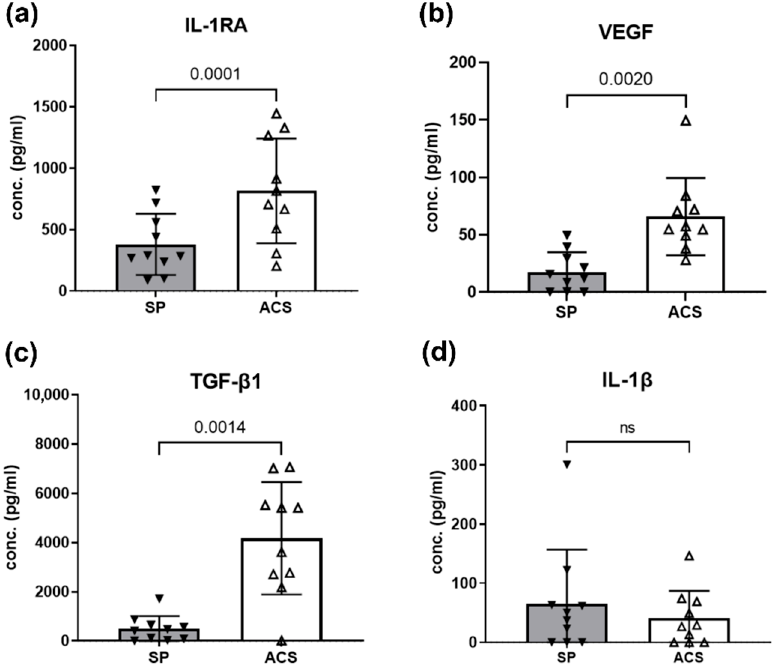
Figure 1. Growth factor and anti-inflammatory cytokine levels of ACS and SP derived from dogs with spontaneous OA. Bar graphs show the cytokine components in response to ACS as evaluated by ELISA. The levels of ( a ) IL-1RA, ( b ) VEGF, and ( c ) TGF- β 1 in the ACS group were significantly higher than in unprocessed plasmas. P values were reported as indicated. There was a limited concentration of ( d ) IL-1 β and IL-10 (graph not shown; data in Results). No significant difference of IL-1 β level was observed in both groups. TNF- α concentration was below the detectable range of the kits. Filled and blank triangles represent the mean results obtained from 10 OA dogs with three independent replications and technical triplicates in each round. Error bars depict means with SDs in all panels. For all Figures, the statistical significance was assessed using a two-tailed paired sample t-test. Abbreviations, ACS; Autologous conditioned serum, SP; Sham plasma, IL-1RA; Interleukin-1 Receptor Antagonist, VEGF; Vascular Epithelial Growth Factor, TGF- β 1; Transforming Growth Factor beta 1, IL-1 β ; Interleukin-1 beta, conc.;